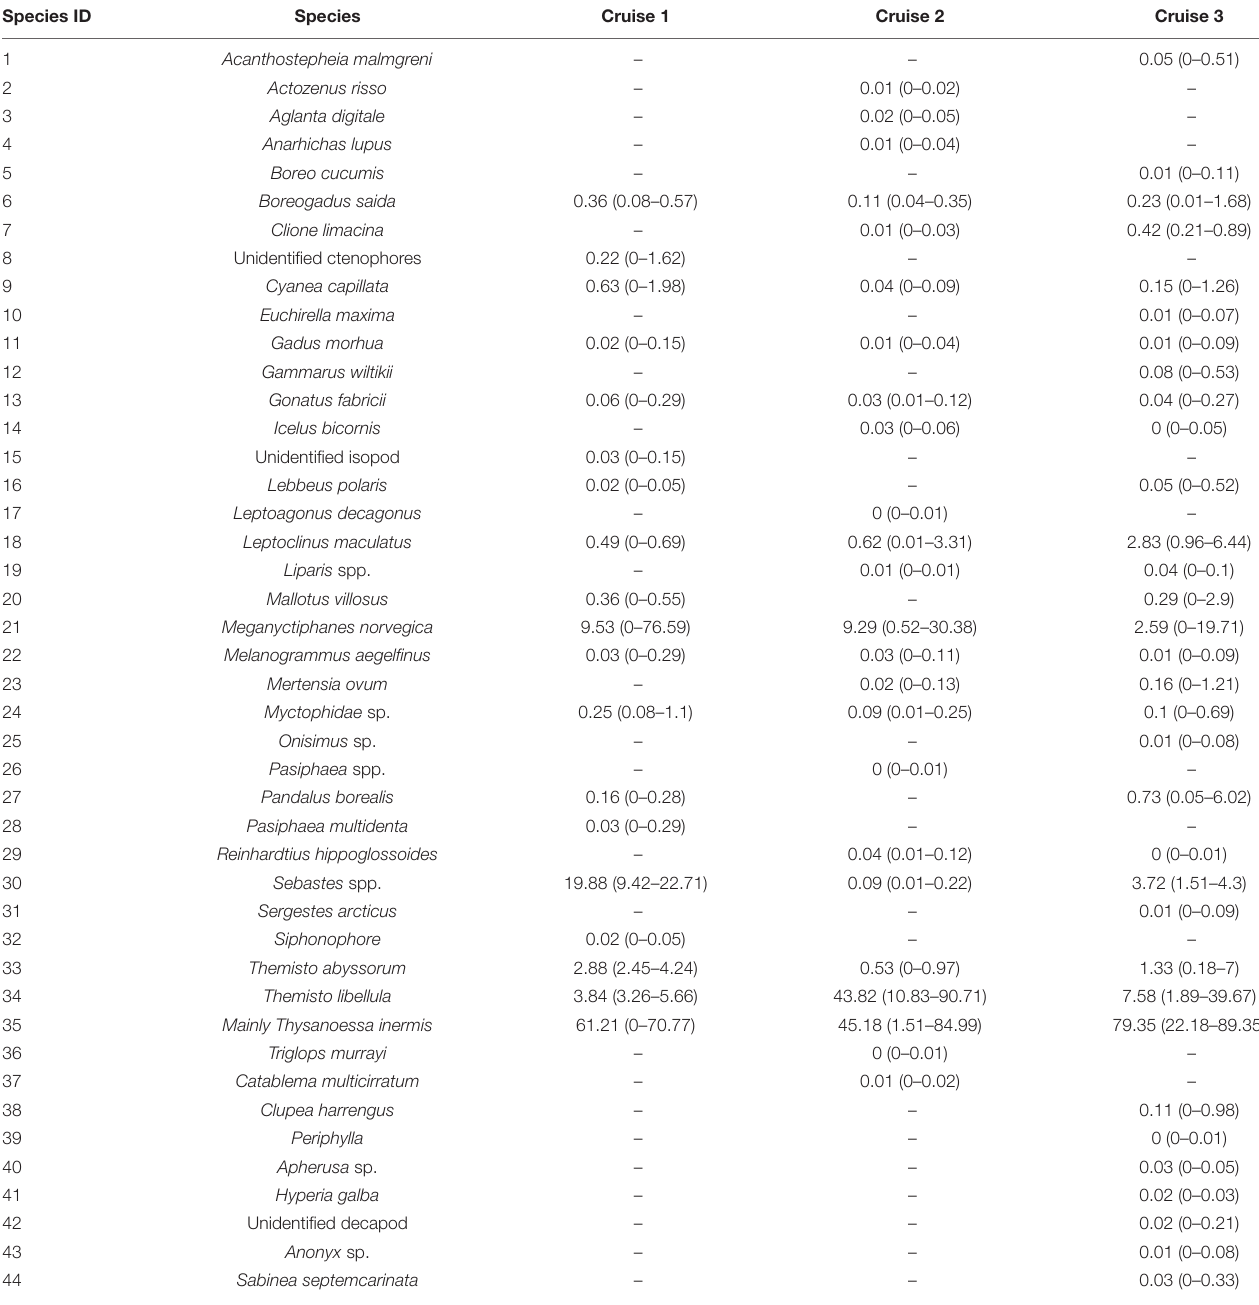
TABLE 2 | Species dominance values d ij according to Eq. (8) for each cruise. Values in parentheses represent 95% confidence